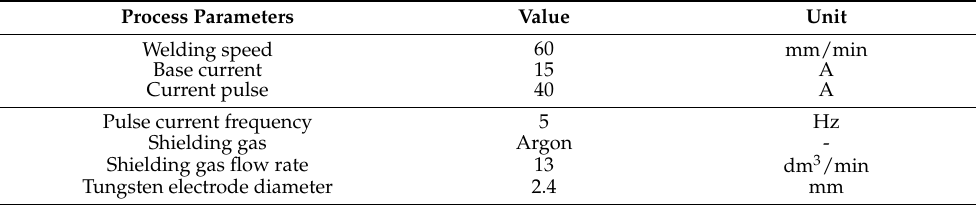
Table 3. Process parameters employed in the TIG welding of AMS